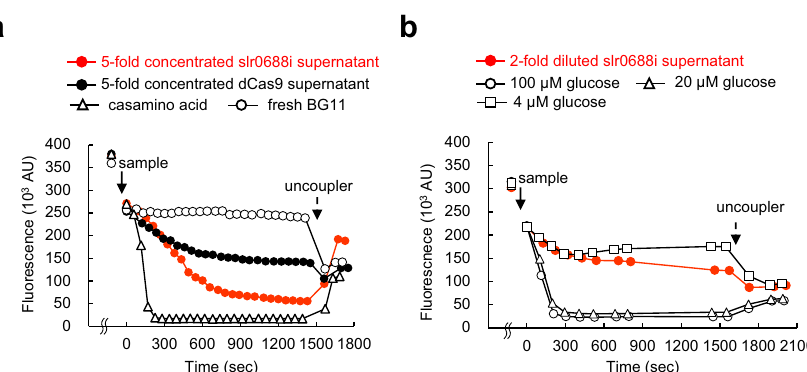
Fig. 4 Generation of membrane potential of Bacillus cells by supernatant of slr0688i. Changes in membrane potential of Bacillus cells were monitored (for detail, see Materials and Methods) following addition of each sample at the time indicated by bold arrows ( t = 0): ( a ) 5× concentrated supernatants with MW > 3000 of slr0688i (red circles) and dCas9 (black circles), fresh BG11 (white circles), and 0.01% (w/v) casamino acid in BG11 (white triangles), ( b ) a 0.5× concentration of slr0688i supernatant (red circles), 100 µ M (white circles), 20 µ M (white triangles), 4 µ M (white squares) glucose in BG11. At the time indicated by dotted arrows, uncouplers were added to dissipate the membrane potential: ( a ) 5 µ M gramicidin, ( b ) 4 µ M valinomycin. Source data are provided as a Source Data